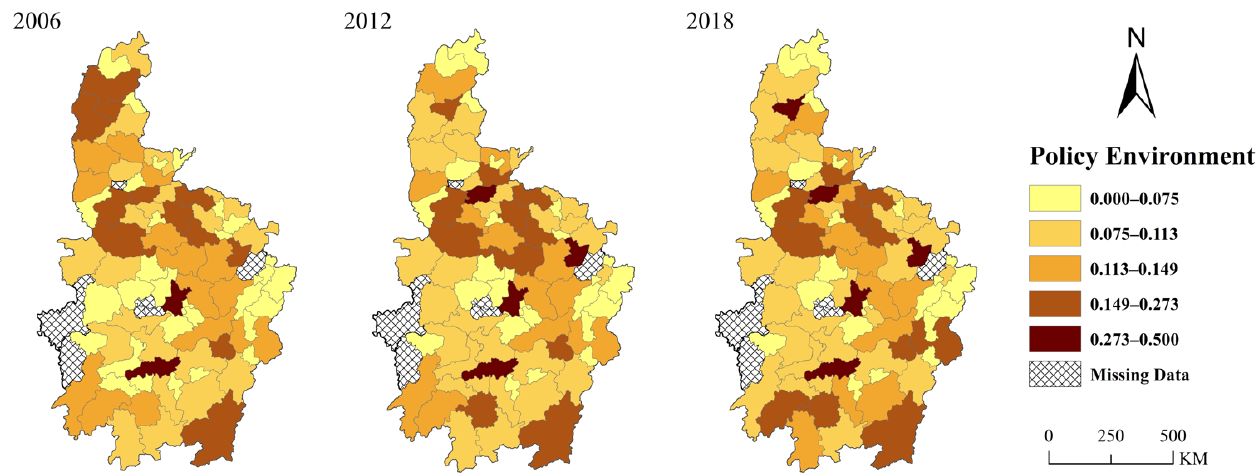
Figure 3. Spatial variation of policy Environment in Central China. Note: Built by the authors based on the data calculated through above method.